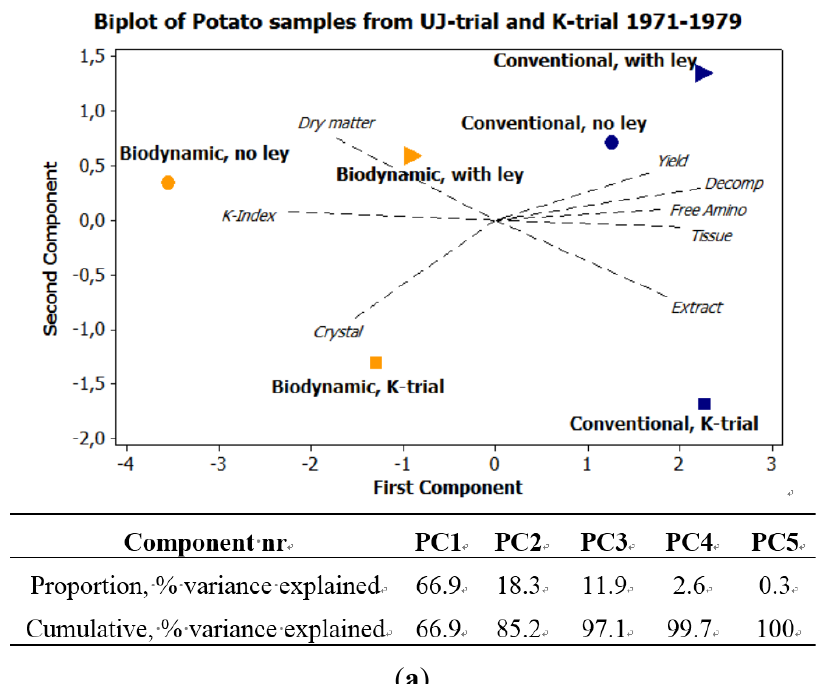
Figure 1. PCA plot on weather conditions at location of field trials 1970–1989, TempJune = Daily temperature sum from 1 April to 30 June, TempOct = Daily temperature sum from 1 July to 31 October, TempSeas = Daily temperature sum from 1 April to 31 October, RainJune = Sum of precipitation from 1 April to 30 June, RainOct = Sum of precipitation from 1 July to 31 October, RainSeas = Sum of precipitation from 1 April to 31